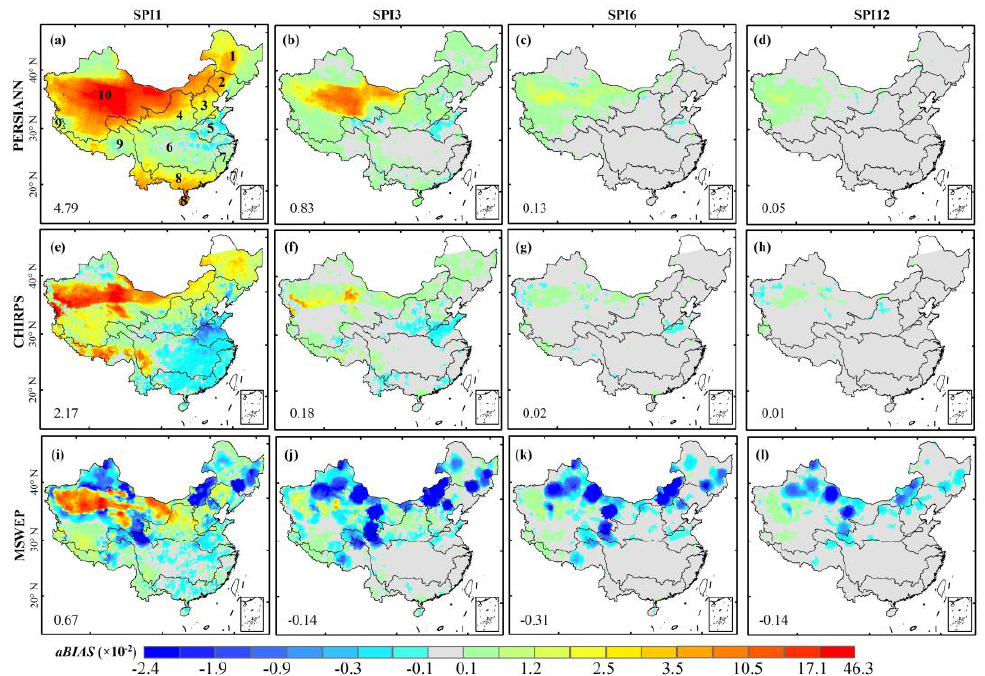
Figure 8. The same as Figure 7, but for absolute bias. ( a , e , i ) SPI1. ( b , f , j ) SPI3. ( c , g , k ) SPI6. ( d , h , l ) SPI12. The numbers in ( a ) indicate: 1—the Song Hua River, 2—the Liao River, 3—the Hai River, 4—the Yellow River, 5—the Huai River, 6—the Yangtze River, 7—southeastern rivers, 8—the Pearl River, 9—southwestern rivers, 10—northwestern